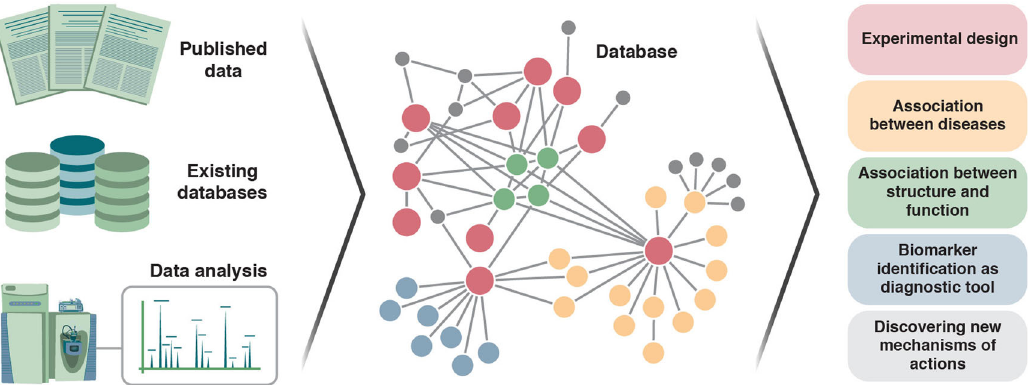
Fig. 2 Metaboloinformatics. Establishment of an inclusive database that connects between metabolites and their related pathologies would allow a variety of applications, including improved experimental design and functional